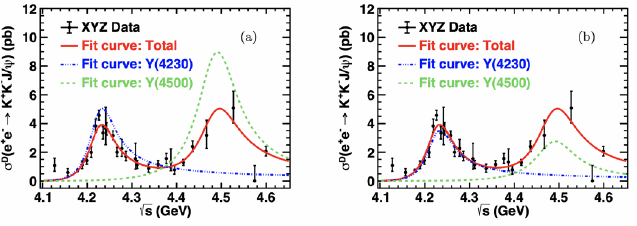
K + K − J /ψ channel. (a) corresponds →